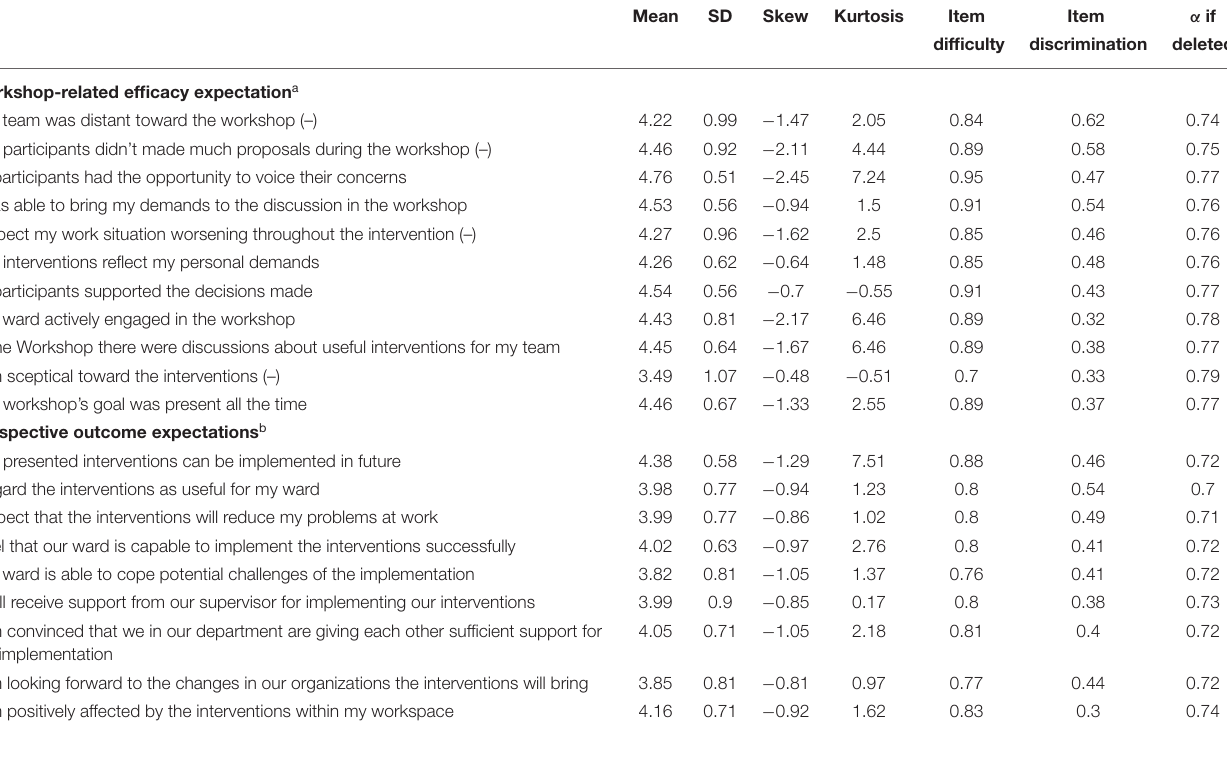
TABLE 4 | Item descriptive statistics and scale reliability analysis ( N = 125).